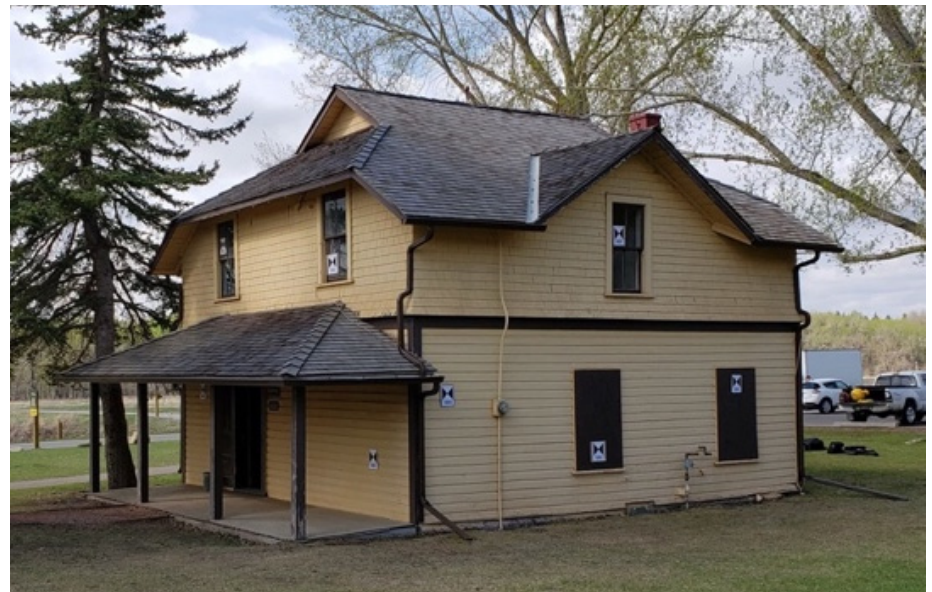
Figure 9. Jobber’s House, Fish Creek Provincial Park.